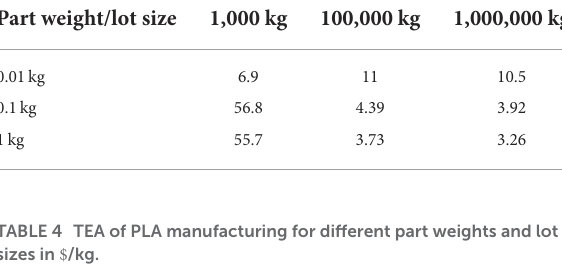
TABLE 3 TEA of PP manufacturing for different part weights and lot sizes in $ /kg.